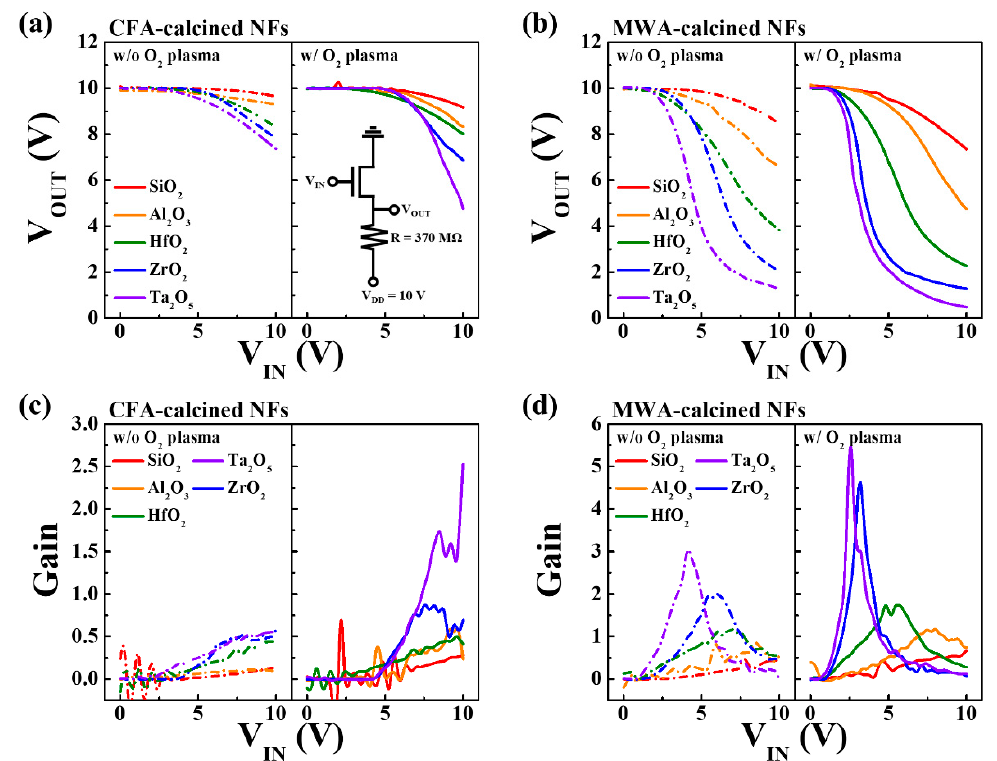
Figure 8. Voltage transfer characteristic (VTC) curves of resistor-loaded inverters based on ( a ) CFA- and ( b ) MWA-calcined IGZO NF FETs with different high- k dielectrics. Gains of inverters with ( c ) CFA- and ( d ) MWA-calcined IGZO NF FETs. Dashed and solid lines represent data for FETs obtained before and postcalcination oxygen plasma treatment, respectively.